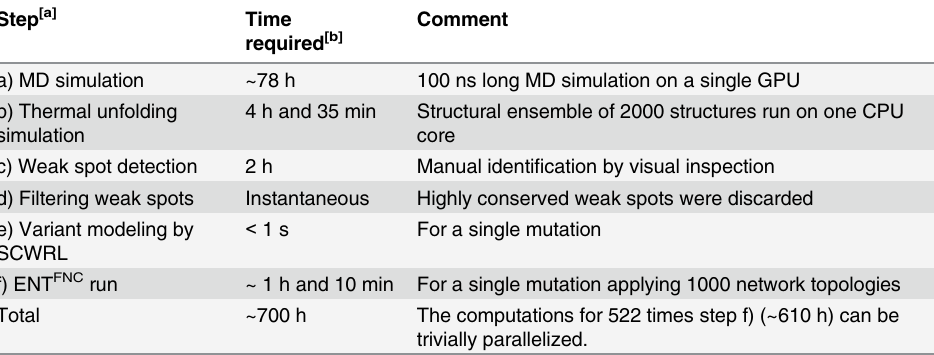
Table 4. Computing times for weak spot identification, site saturation mutagenesis, and screening for increased structural